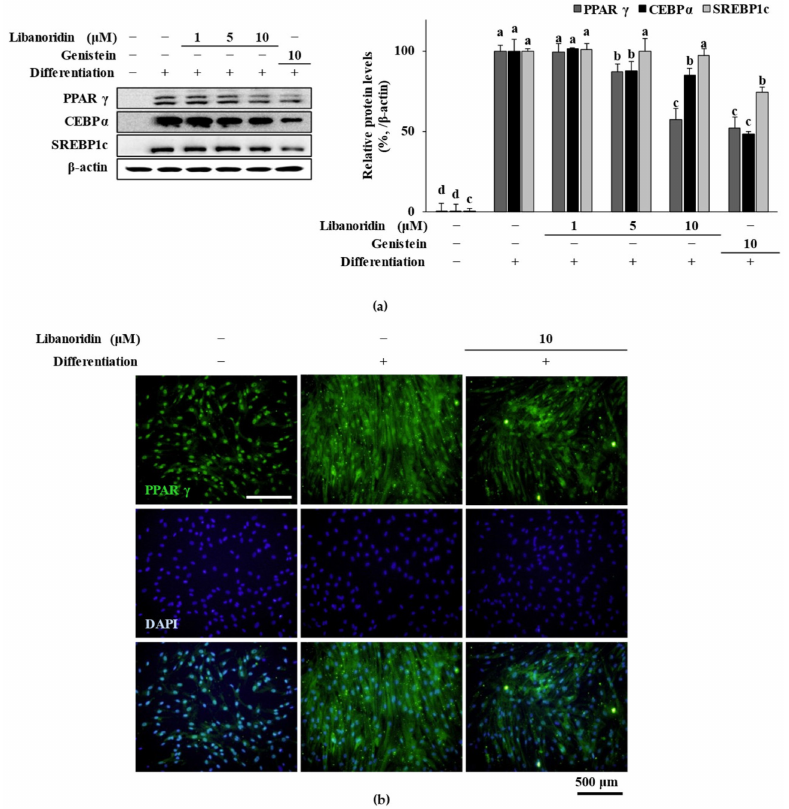
Figure 3. Effect of libanoridin on protein levels of adipogenic transcription factors. ( a ) Protein expression levels of PPAR γ , C/EBP α , and SREBP1c in adipo-induced hBM-MSCs were analyzed by Western blotting at day 7 of differentiation. β -actin was used as an internal loading control. Values are means ± SD ( n = 3). a–d Bars with identical letters indicate no statistical significance ( p < 0.05), while different letters indicate otherwise. ( b ) The intracellular PPAR γ protein levels were investigated by fluorescence staining (green). DAPI staining was employed (blue) to highlight the viable cell